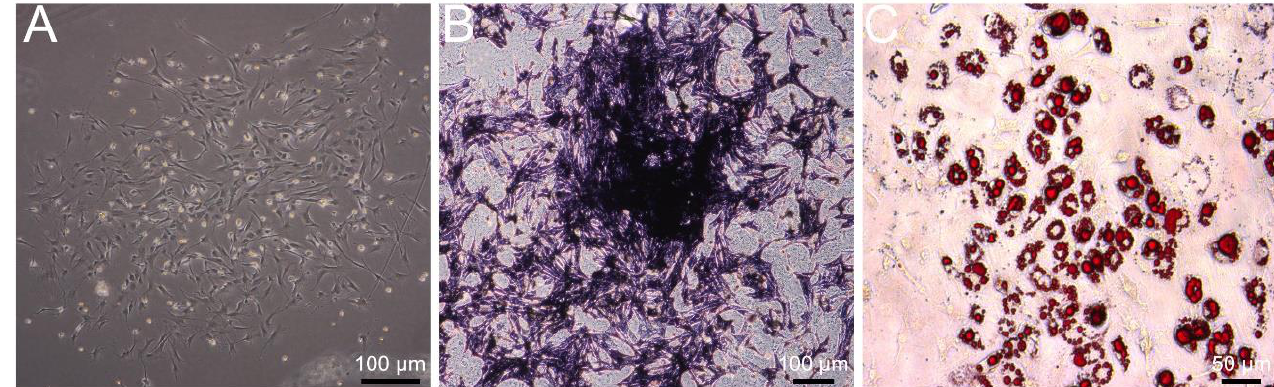
Figure 1. Identification of primary BMSCs from mice. ( A ) Image of BMSCs morphology at the third passage. ( B ) The BMSCs were stained by alkaline phosphatase (ALP) after 14 days of osteogenic differentiation. ( C ) The BMSCs were stained with Oil Red O after 14 days of adipogenesis induction. BMSCs, bone marrow mesenchymal stem cells.